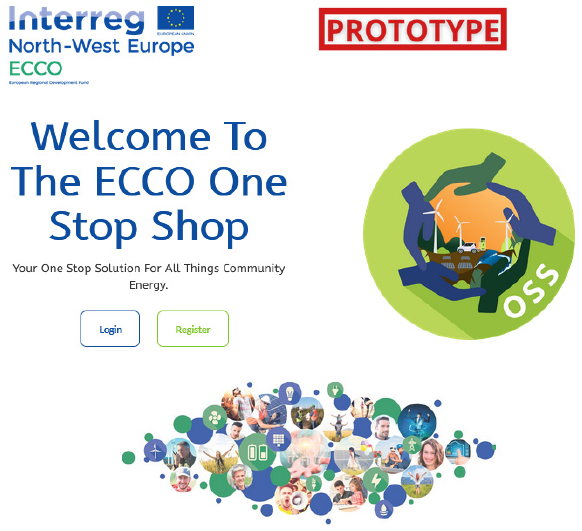
Figure 3. The landing page of ECCO OSS.